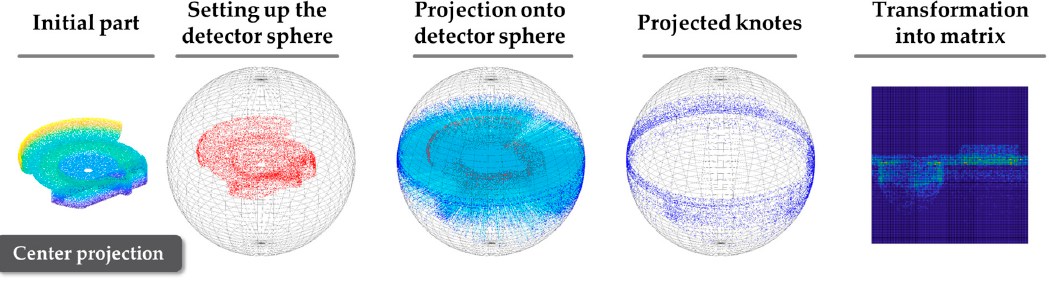
Figure 2. Process steps of the projection method for generating the node matrix according to [15,16].